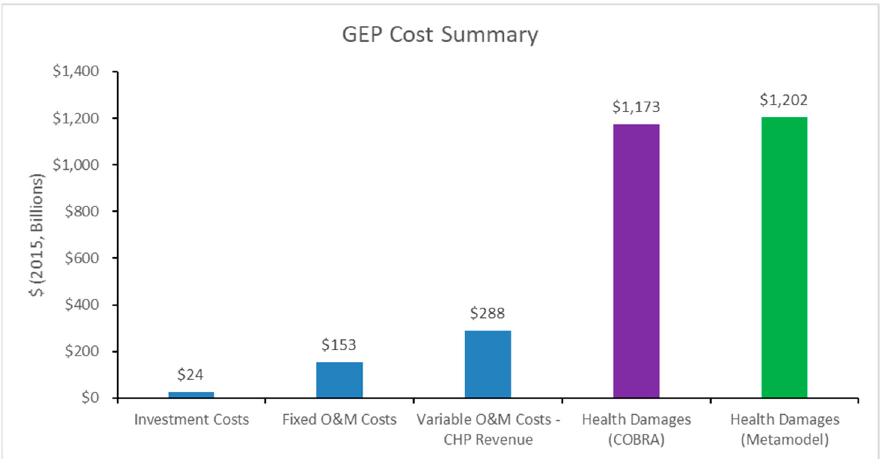
Figure 6. Total Cost Output Summary.